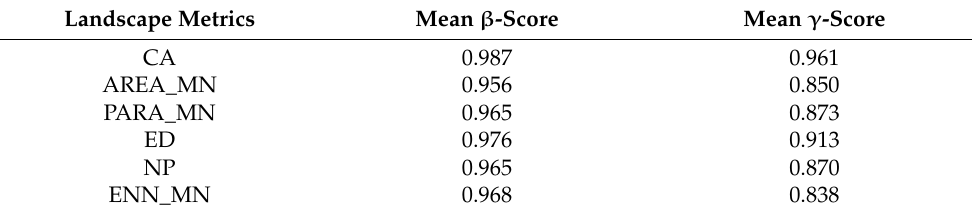
Table 4. Mean β -score and mean γ -score of the landscape metrics used in this study. Landscape Metrics Mean β -Score